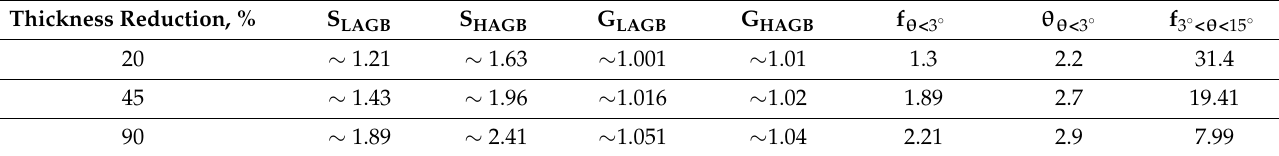
Table 2. The average aspect ratio of LAGBs and HAGBs, and theirs corresponding shape effect (G).